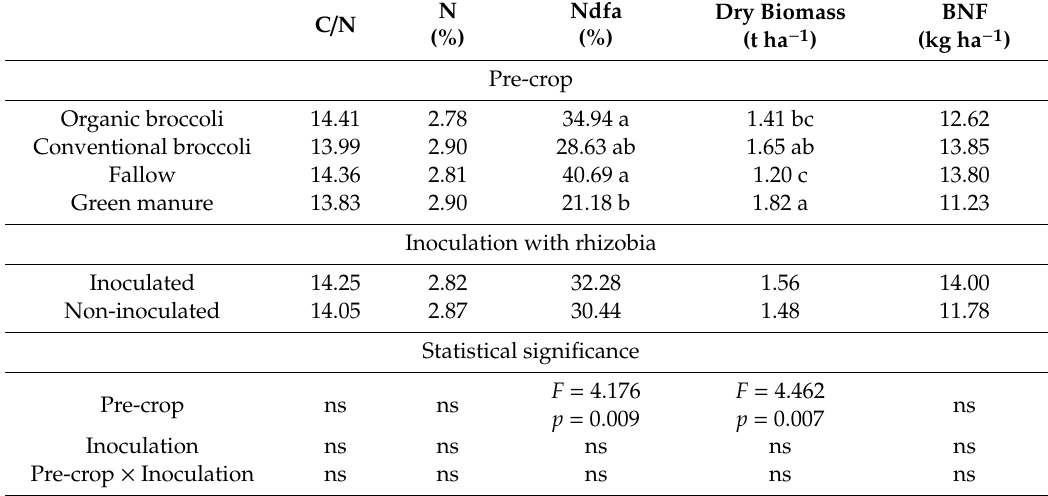
Means of pre-crop treatment (n = 8) and inoculation with rhizobia (n = 16) followed by di ff erent letters within the same column indicate significant di ff erences for both factors, according to Duncan’s multiple range test. ns = not significant. Table 7. Impact of the di ff erent pre-crop treatment and inoculation of common bean with Rhizobium tropici CIAT 899 on C / N ratio, N concentration (%), %Ndfa, dry biomass (t ha − 1 ), and amount of biologically fixed N (BNF, kg ha − 1 ) of common bean cultivated during spring-summer 2019.